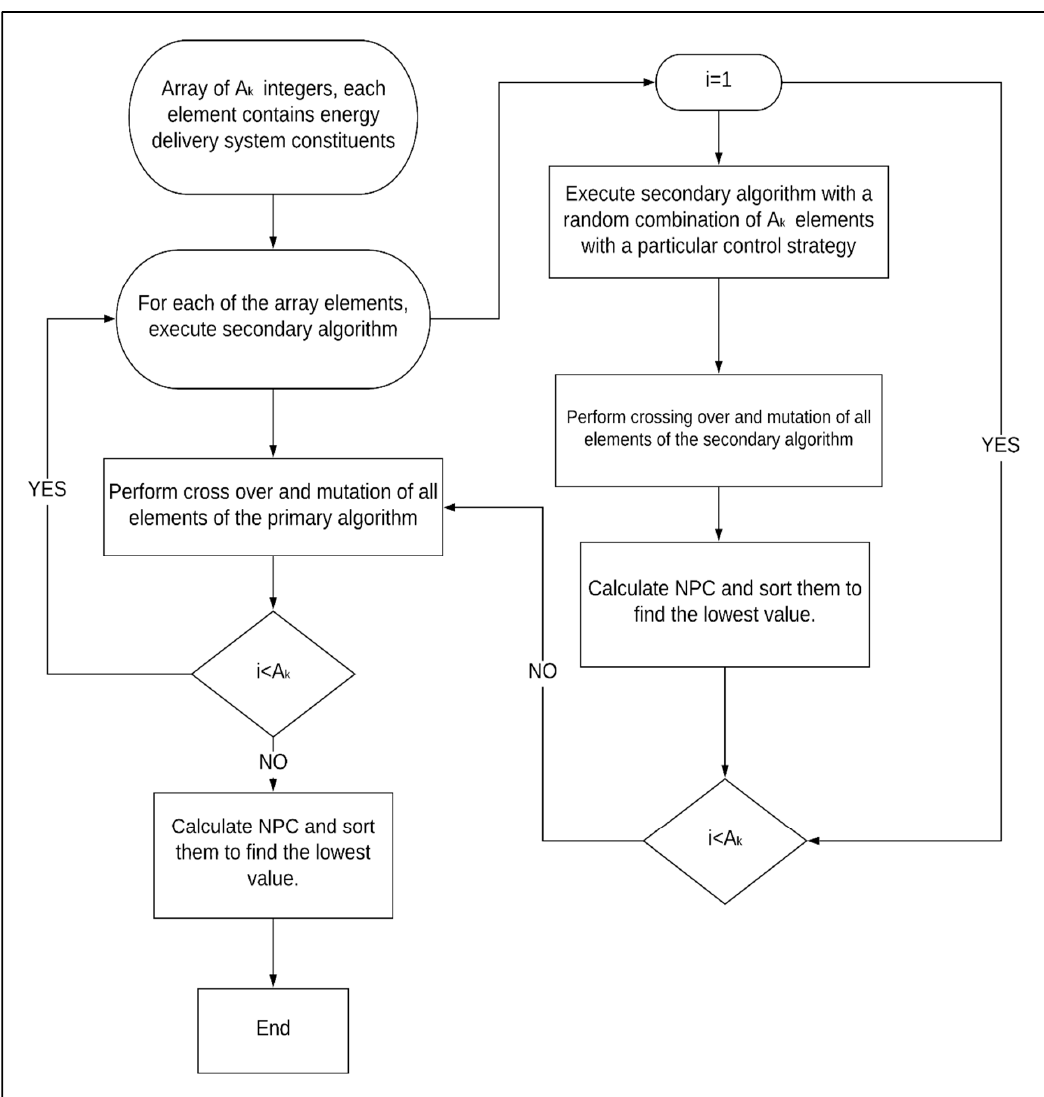
Figure 6. Flowchart used by iHOGA.